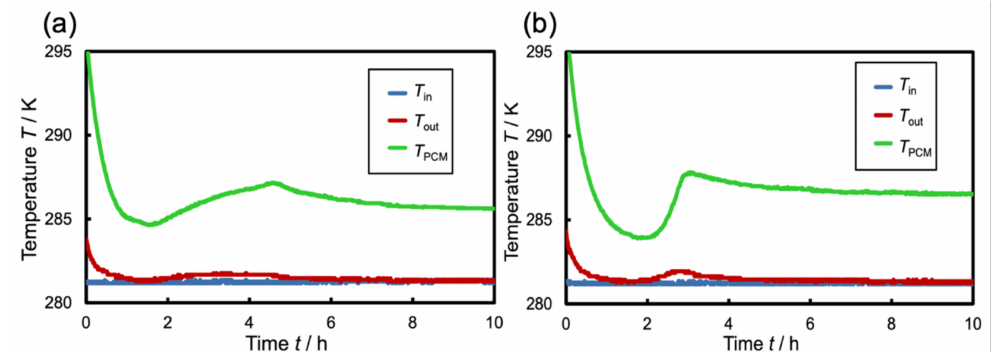
Figure 9. Time evolutions of the temperature at inlet of the chiller (T in ), outlet (T out ) of the chiller and thermal energy storage medium (T PCM ) in the system with ultrasonic vibration. ( a , b ) depict each curve at the frequency of 28 kHz and 56 kHz,